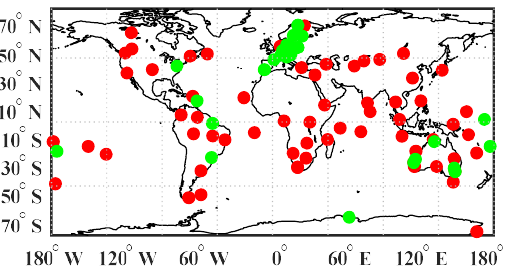
Figure 8. Ninety-seven MGEX stations for single point positioning (SPP), including the same 64 stations (red dots) in the network solution and 33 new stations (green dots) .